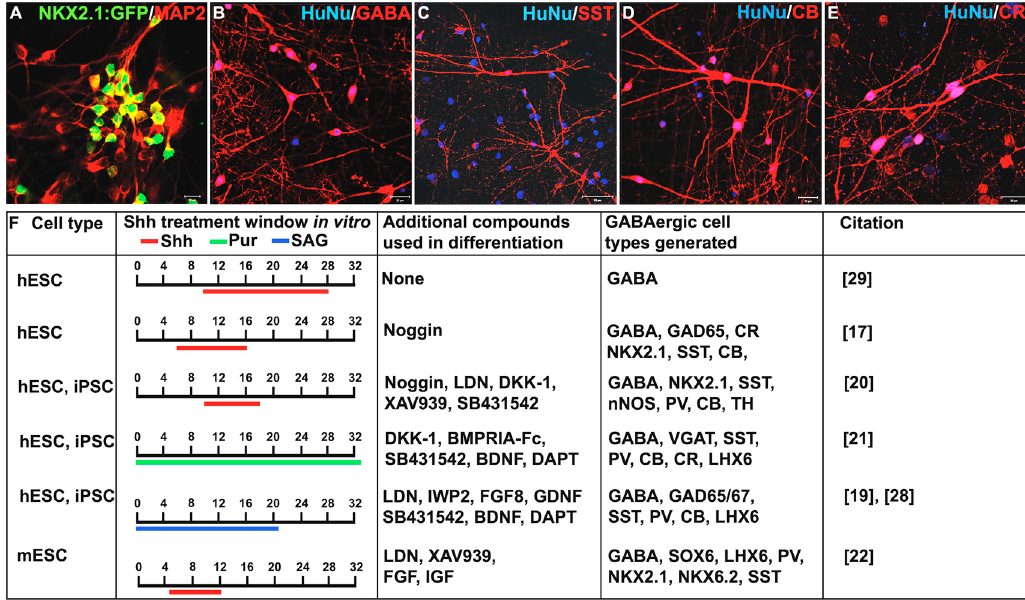
Figure 2. Comparison of protocols used to generate gamma-aminobutyric acid-containing GABAergic inhibitory interneurons from a PSC source. ( A – E ) NKX2.1 -positive progenitors give rise to various interneuron subtypes in a co-culture system with mouse cortical astrocytes. Significant NKX2.1:GFP, MAP2, and calretinin (CR) protein expression observed after 10 weeks of co-culture and robust calbindin (CB), neuropeptide somatostatin (SST), and gamma-aminobutyric acid (GABA) expression seen after 17 weeks in vitro; ( F ) comparison of published protocols for the in vitro generation of GABAergic interneurons showing the time window of Sonic hedgehog (Shh) and Smoothened (Smo) agonist treatment, as well as additional exogenous compounds used in promoting neural differentiation. Scale bars: A = 10 µ M, B–E = 20 µ M. hESC = human embryonic stem cells, iPSC = induced pluripotent stem cells, mESC = mouse embryonic stem cells, Pur = purmorphamine.